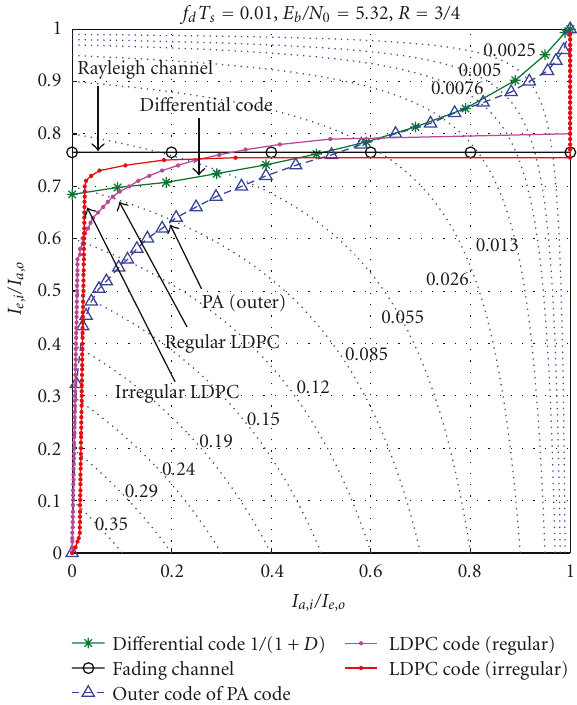
Figure 1: EXIT curves of LDPC codes, the outer code of PA codes, di ff erential decoder and the direct detector of Rayleigh channels. Normalized Doppler rate 0.01, E b /N 0 = 5 . 32 dB, code rate 3/4, (3,12)-regular LDPC code, and optimized irregular LDPC code with ρ ( x ) = x 20 and γ ( x ) = 0 . 1510 x +0 . 1978 x 2 +0 . 2201 x 6 +0 . 0353 7